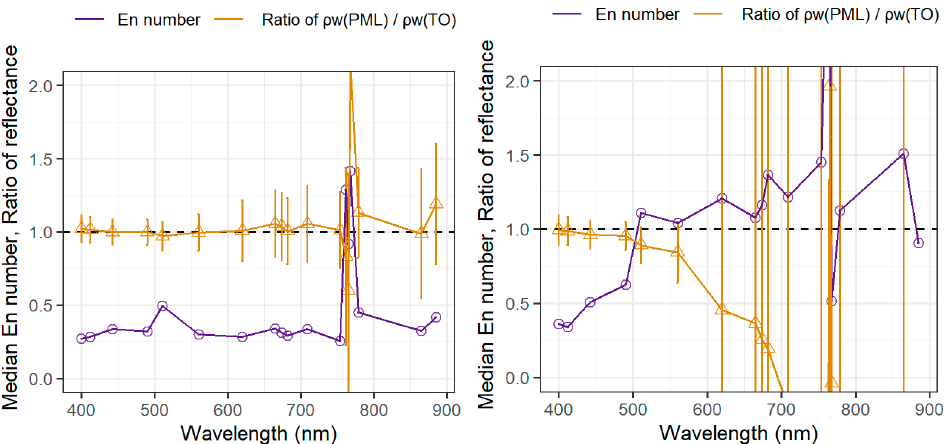
Figure 10. Comparison PML / TO averaged results for ρ w , before (left) and after (right) NIR similarity corrections. Mean ratio with uncertainty bars—yellow line (triangles); Median of respective E n values—purple line (circles).